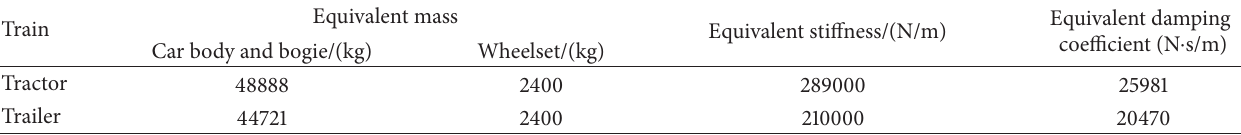
Table 2: Effective calculation parameters of